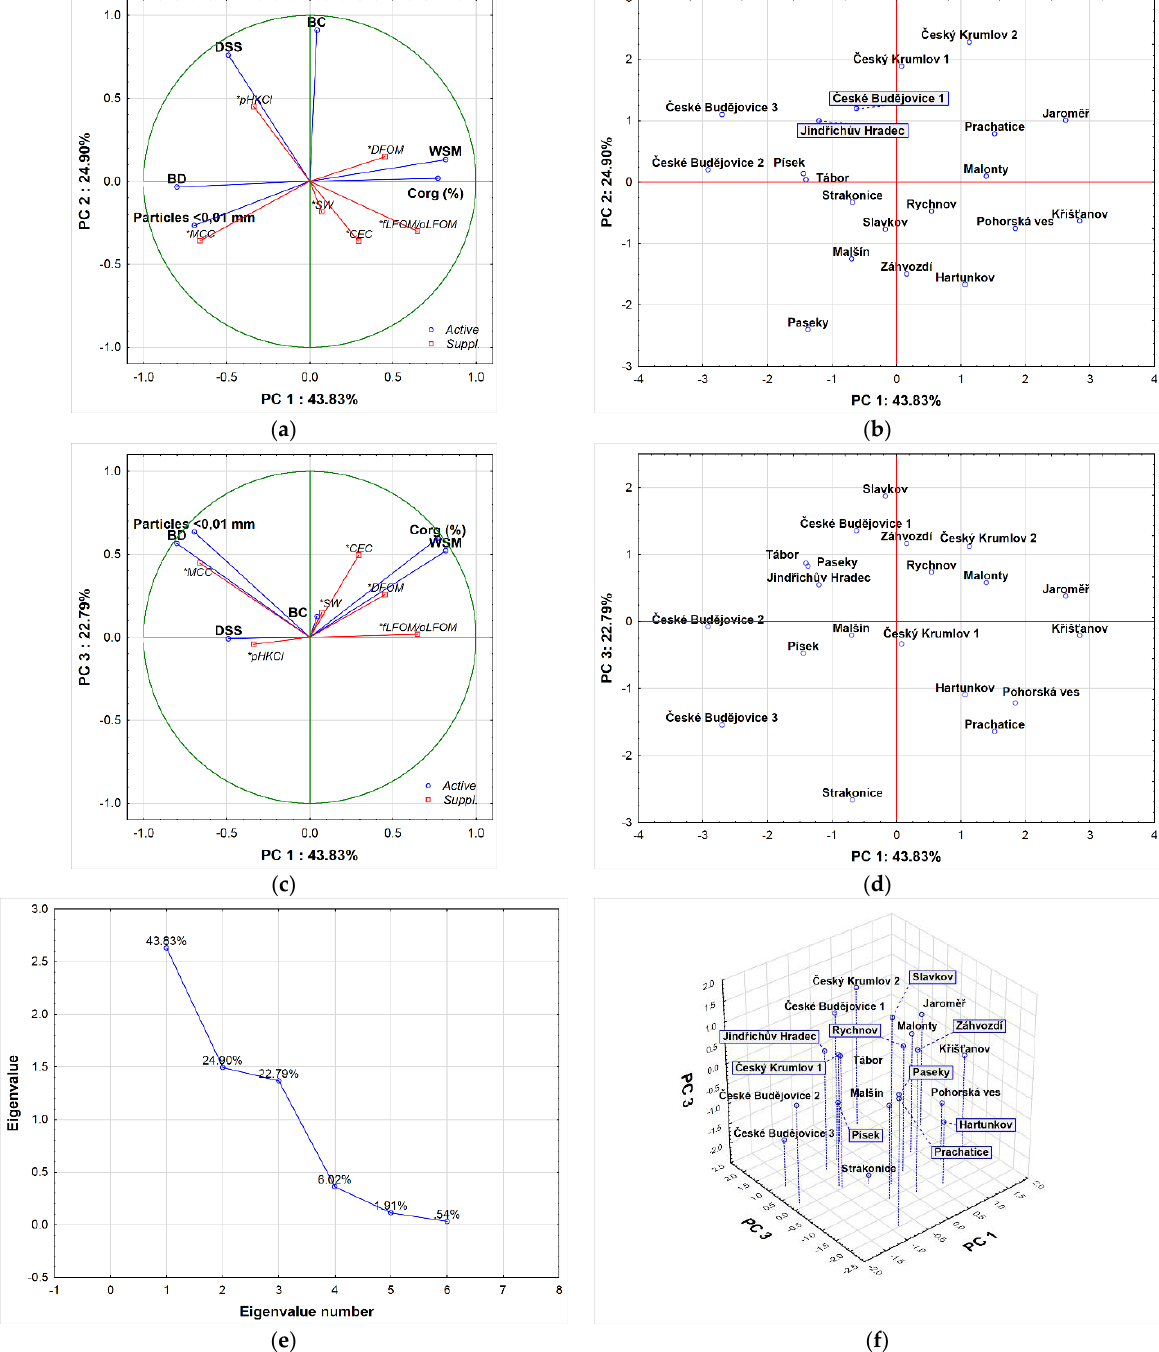
Figure 3. Principal component analysis (PCA) of soil quality parameters in the area of interest: ( a ) graph of component weights 1 a 2 (PC1 × PC2) for soil quality parameters. ( b ) The scatterplot of the component score PC1 × PC2 for individual localities. ( c ) Graph of component weights 1 a 3 (PC1 × PC3) for soil quality parameters. ( d ) The scatterplot of the component score PC1 × PC3 for individual localities. ( e ) Scree plot; ( f ) 3D graph PC1 × PC2 × PC3 for individual localities. Note: BC—black carbon (% C org ); fLFOM/oLFOM—the ratio of free light fraction and the occluded light fraction of soil organic matter; DFOM—the organic matter of the heavy soil fraction (% C of soil); WSM—water-stable macroaggregates (g aggregates (kg soil after sand subtraction) − 1 ); CEC—cation exchange capacity (mmol/kg); pH KCl —soil reaction; particles <0.01 mm—clay particles; C org —soil organic carbon (%); MCC—maximal capillary capacity (%); SW—specific weight (g/cm 3 ); DSS—degree of sorption saturation (%); BD—bulk density (g/cm 3